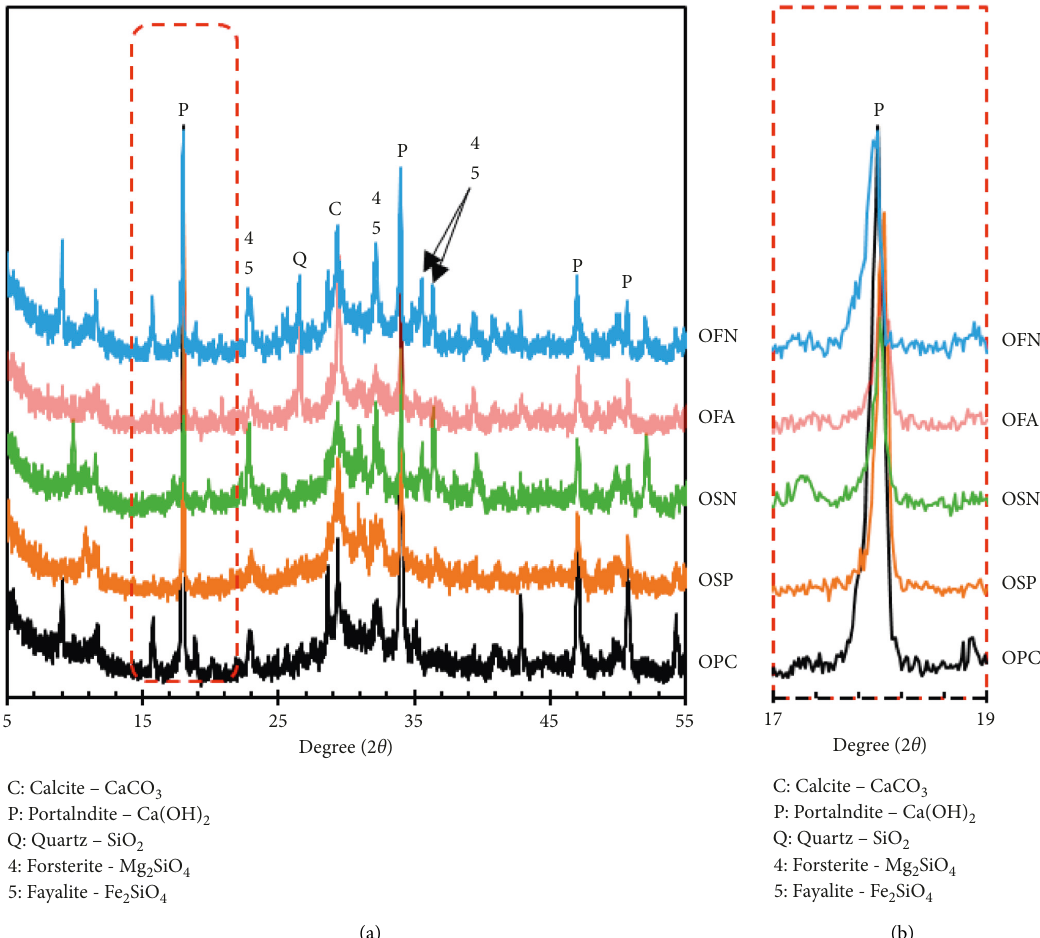
Figure 2: XRD curves of cement pastes cured at 365days with different mix proportions: (a) whole patterns and (b) main peak for portlandite.